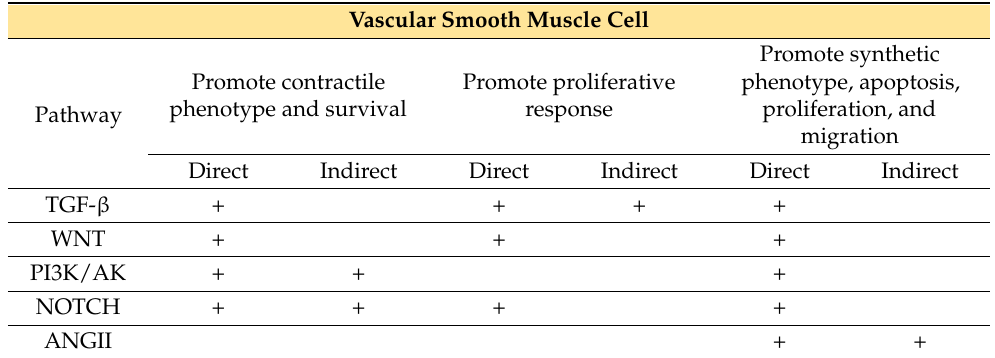
Figure 12. Summary of pathway crosstalk in TAA. Red lines indicate that there is evidence of the interaction in TAA. The large pink arrows indicate increased and/or decreased activity of the pathway in TAA. Table 1. Summary table of evidence for direct and/or indirect effects of pathways in promoting different cellular responses in VSMC and EC. + equals effect observed.